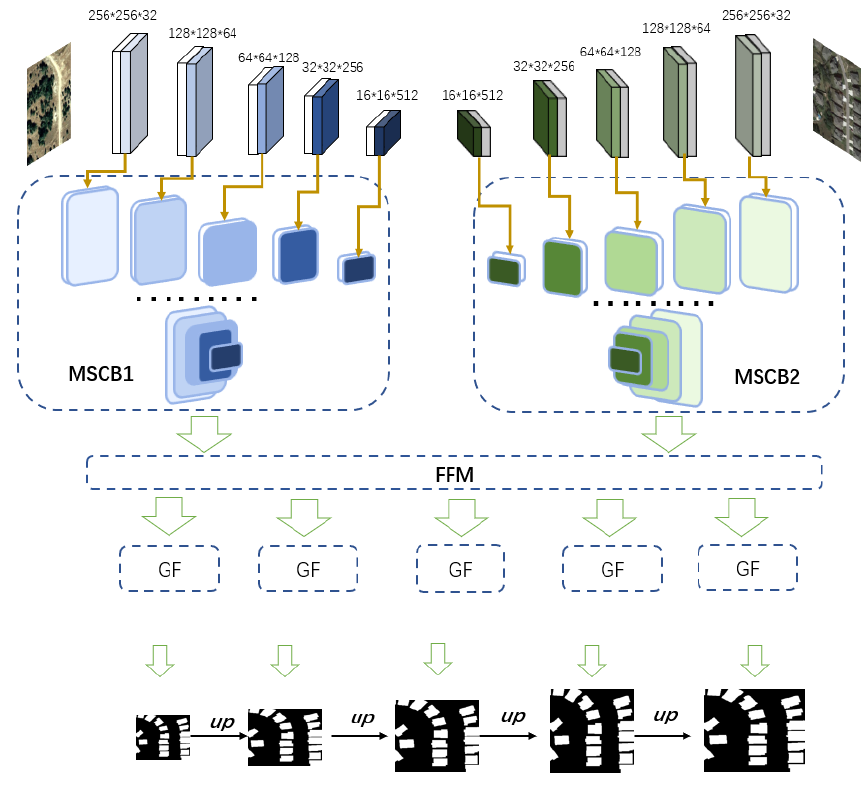
Figure 2. Structure of the MFGFNet.